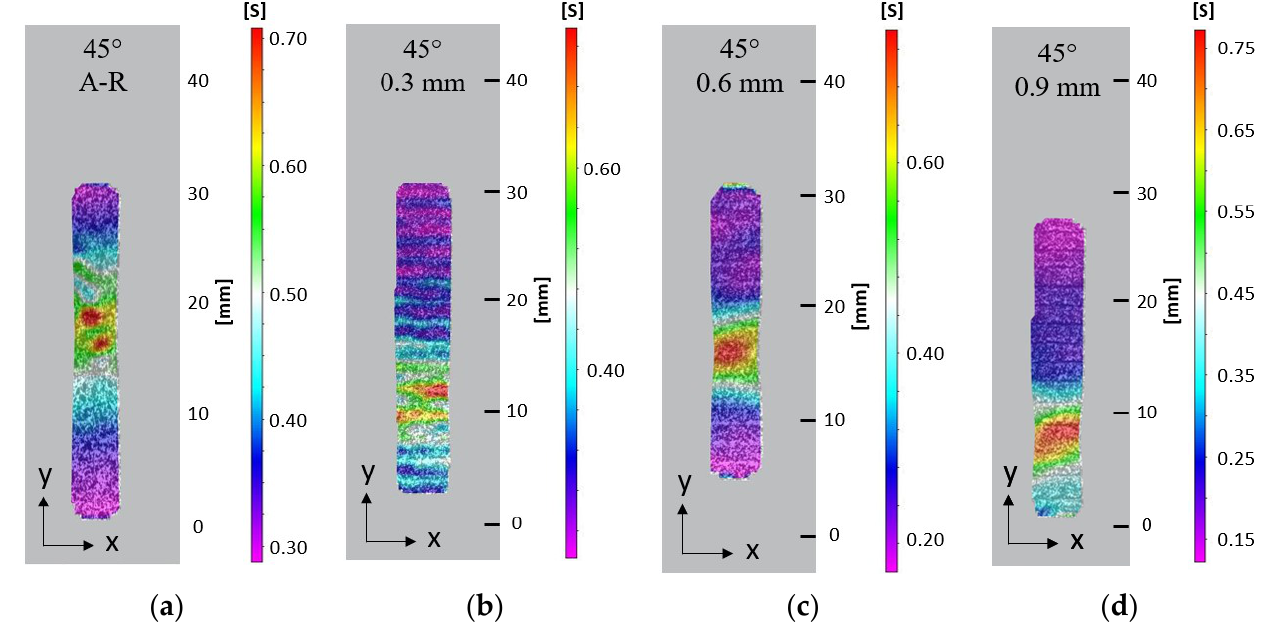
Figure 13. Effective surface strain at 90% extension on tensile samples orientated 45° to substrate RD: ( a ) A-R material; ( b ) 0.3 mm LMD sample; ( c ) 0.6 mm LMD sample; ( d ) 0.9 mm LMD sample.